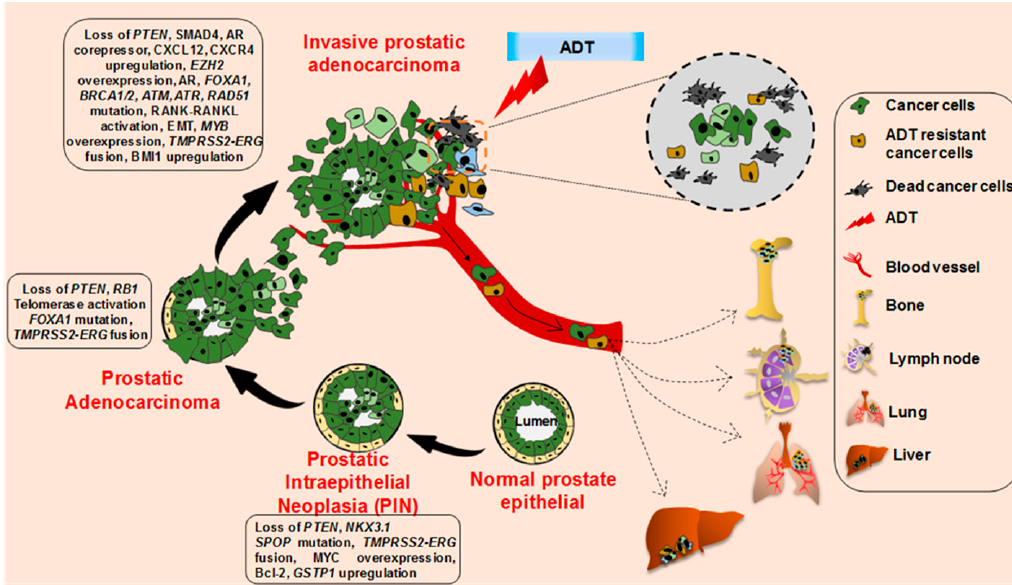
Figure 2. Histopathological and molecular progression of human prostate cancer. Metastatic prostate cancer develops via progression through prostate intraepithelial neoplasia (PIN) and invasive adenocarcinoma through the acquirement of various molecular alterations as depicted. The invasive adenocarcinoma cells and androgen-deprivation therapy resistant cancer cells metastasize to the bone, lymph node, lung, and liver.